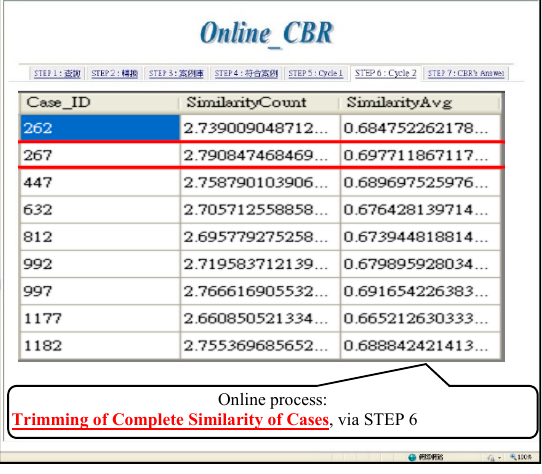
Figure 18. Trimming of complete similarity of cases.